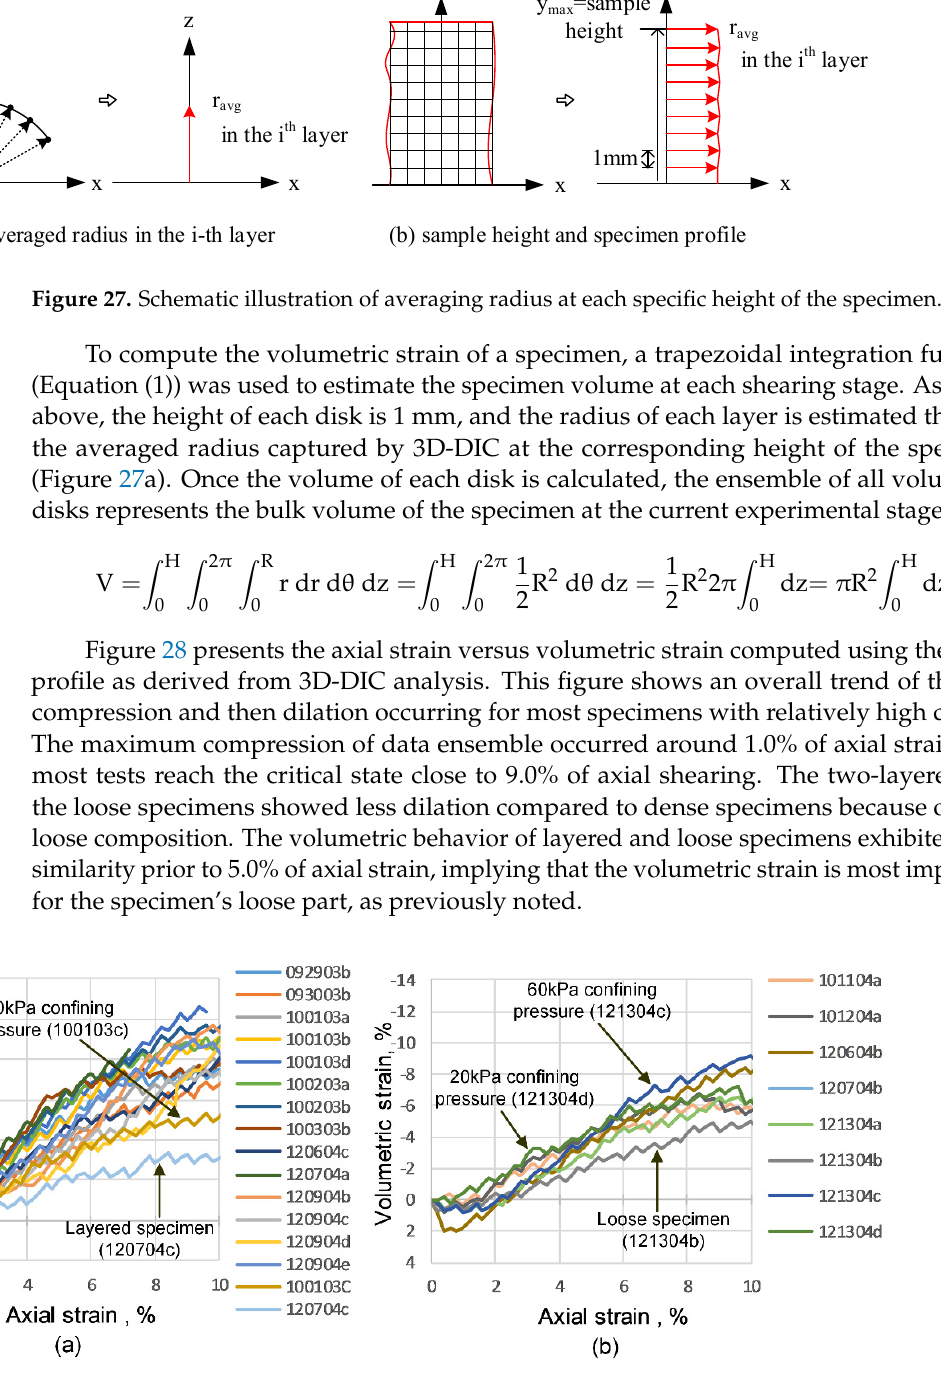
Figure 28. Axial strain versus volumetric strain curves: specimens prepared by vibratory compaction method ( a ) and specimens prepared by the dry pluviation method ( b ).